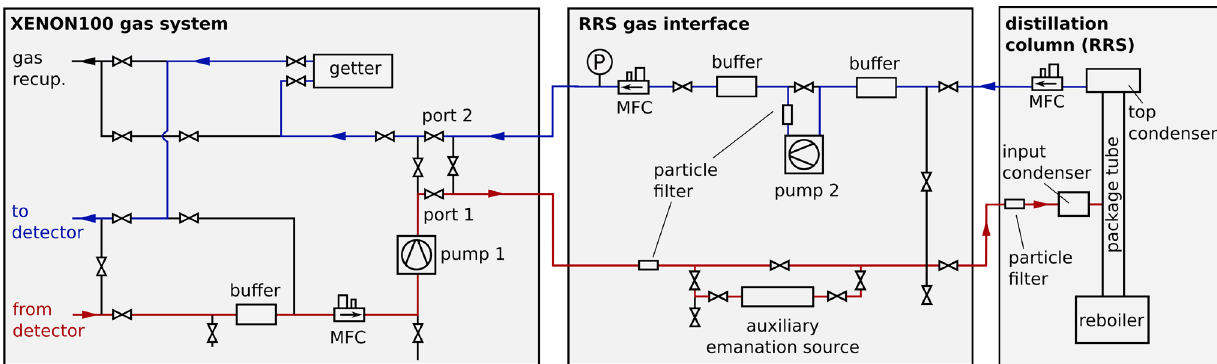
Fig. 1 The xenon coming from the detector is guided from the XENON100 gas system ( left ) via the RRS gas interface ( middle ) to the distillation column ( right ), where radon is removed. The purified xenon is pumped back to the detector via the RRS gas interface. The